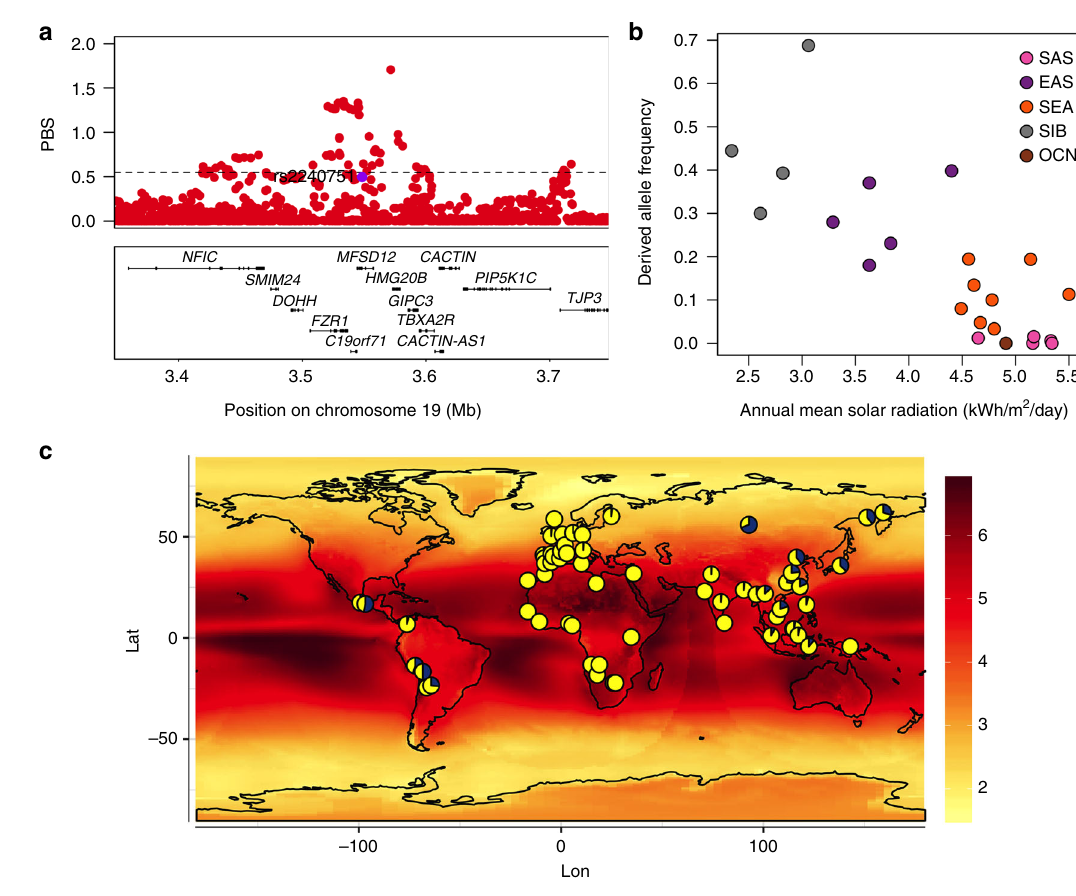
Fig. 8 Evidence for selection in the MFSD12 gene region. a PBS scores in the 1000 Genomes CHB sample for SNPs across the region (index SNP rs2240751 is highlighted in purple and the horizontal black line represents the 99 th percentile threshold). b Plot of the derived allele frequency at rs2240751 against mean annual solar radiation in Easter Eurasian populations. Populations are abbreviated as follows: SAS South Asians, EAS East Asians, SEA South East Asians, SIB Siberians, OCN Oceanians. c Allele frequencies at rs2240751 in 64 native populations from across the world mapped onto solar radiation. Pies charts are centered at the approximate geographic location of each population with the derived allele frequency represented in blue. Geographic coordinates, sample size, mean annual solar radiation and the frequency of the derived allele for each population are shown in Supplementary Table 10